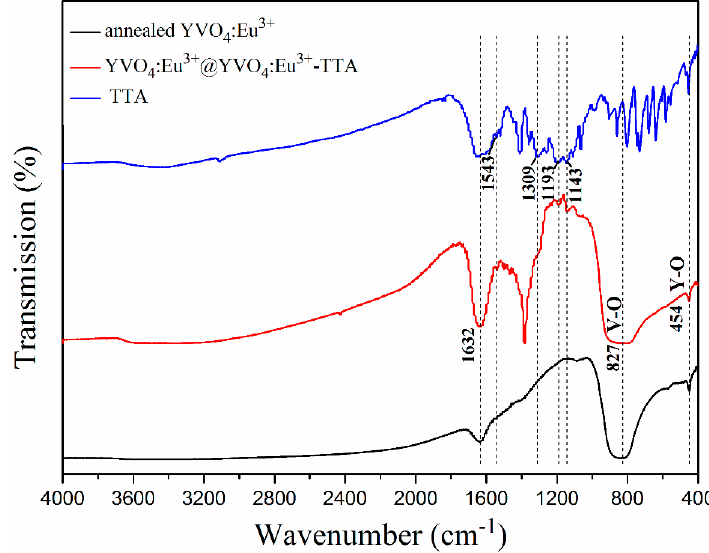
Figure 4. The Fourier transform infrared (FTIR) spectra of 2-thenoyltrifluoroacetone (TTA), the annealed YVO 4 :Eu 3+ nanoparticles and YVO 4 :Eu 3+ @YVO 4 :Eu 3+ –TTA hybrid nanoparticles.